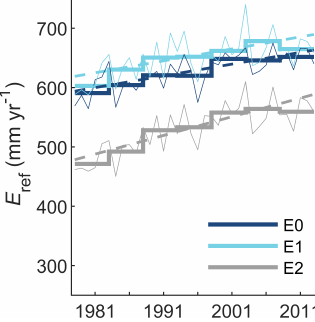
Figure 6. Temporal variations of E ref as calculated by three dif- ferent methods and averaged over all catchments. The thick lines show subperiod means, the thin lines show annual sums, and the broken lines show linear trends; the different colours represent dif- ferent data sets. Calculation of E ref by E 0 – Blaney–Criddle; E 1 – Penman–Monteith; and E 2 – Penman–Monteith using a variable surface resistance based on changes in a satellite-based vegetation